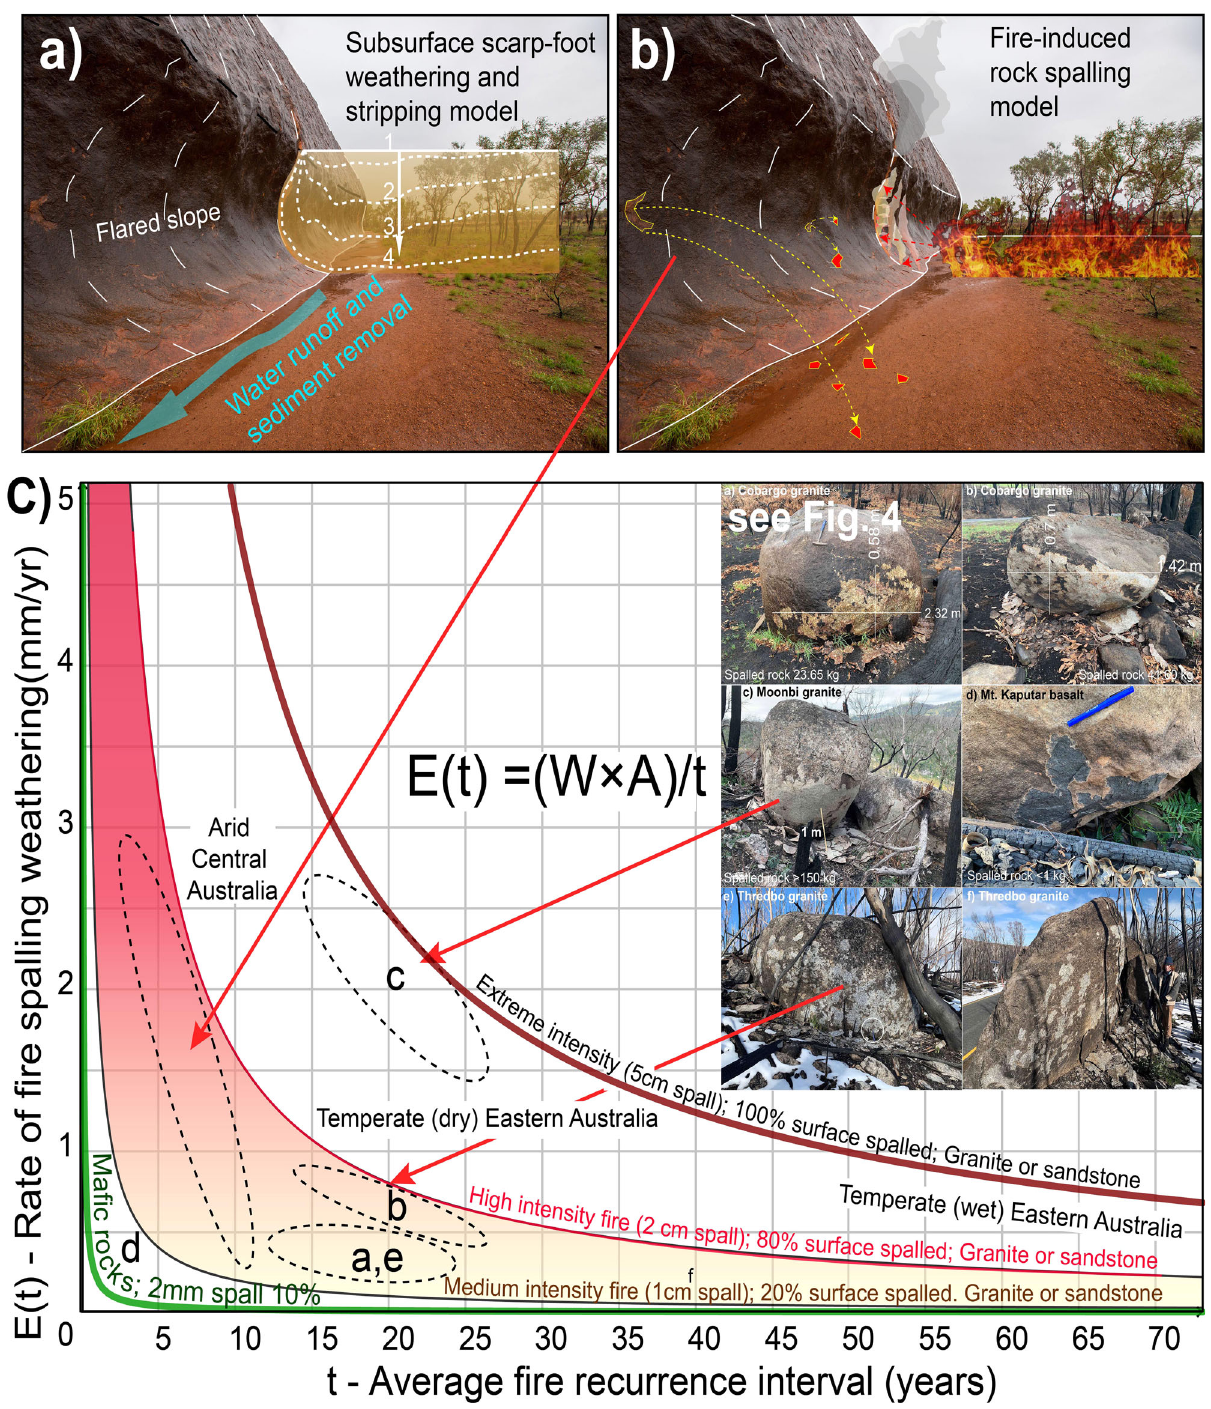
Fig. 6 Existing and new models of fl ared slope development using Uluru as an example and a graphical representation of the formula for erosion due to fi re-spalling in different fi re regimes. a The model of Twidale and Bourne 1998 22 involving subsurface weathering via shallow groundwaters to form soft regolith or unconsolidated soil that is subsequently removed by erosion and landscape lowering; b a new model of fl ared slope development via fi re- induced rock spalling associated with episodic wild fi re events. Note the charcoal on the recently burnt trees is the same height as the fl ared slope; c inverse correlation relationship between rates of erosion E ( t ) plotted against fi re recurrence interval ( t ) using the formula E = W.A / t (see https://www.geogebra. org/calculator/uwa68amr). Rock-type and fi re temperatures tend to control the thickness of spalled sheets ( W ) whilst fi re intensity and duration are the main controls on the surface area spalled (0 – 100%). The inverse correlation of rates of fi re-spalling erosion with average recurrence intervals ( t ) results in an increasing rate of weathering with smaller average fi re recurrence intervals. Fire recurrence intervals are largely controlled by climatic and vegetation regimes and examples from Figs. 2 and 4 are shown and plotted on the graph according to the fi re recurrence interval for that